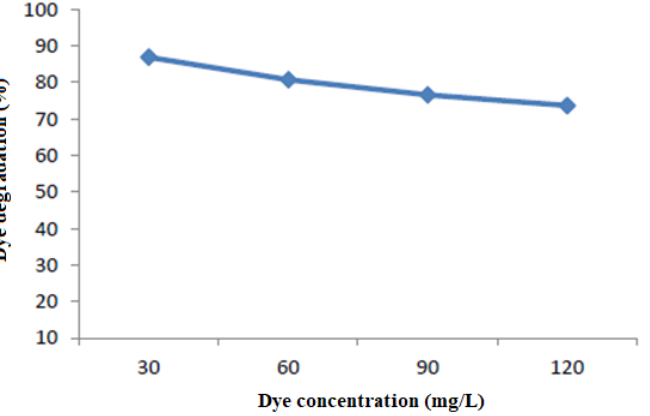
Figure 6. Effect of initial concentration of the degradation of Reactive Yellow 160A (TiO 2 = 450 mg/L, pH = 3, H 2 O 2 = 0.8 mL, irradiation time = 120 min).